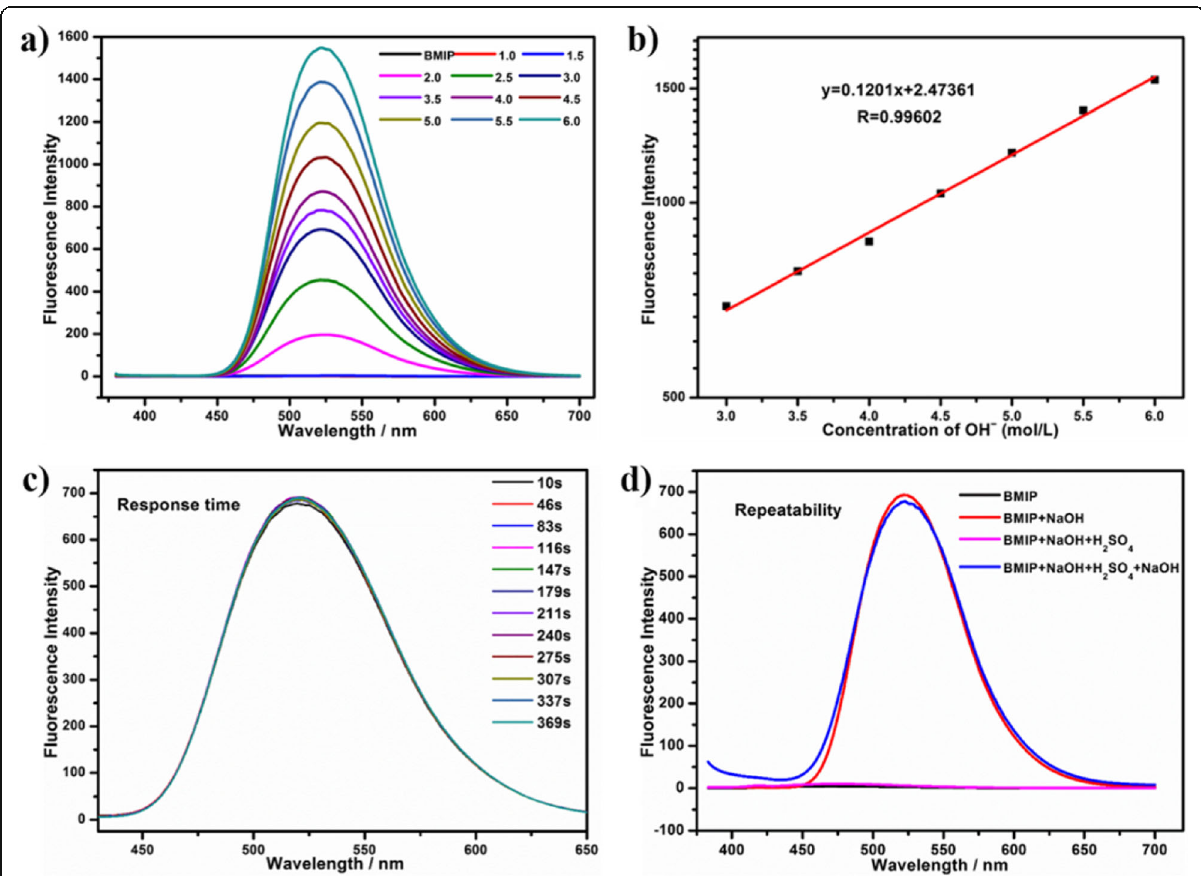
Fig. 4 a The PL spectra of aqueous solutions (1 mmol/L) of BMIP with different concentrations (0, 1.0, 1.5, 2.0, 2.5, 3.0, 3.5, 4.0, 4.5, 5.0, 5.5, 6.0 mol/ L, respectively) of OH ˉ . b The changes of fluorescence intensities of BMIP solutions (1 mmol/L) with different concentrations (3.0, 3.5, 4.0, 4.5, 5.0, 5.5, 6.0 mol/L, respectively) of OH ˉ in water. c The PL spectra of aqueous solution (3 mol/L OH ˉ ) of BMIP (1 mmol/L) at different times (10 s, 46 s, 83 s, 116 s, 147 s, 179 s, 211 s, 240 s, 275 s, 307 s, 337 s, 369 s, respectively). d The PL spectra of aqueous solutions (1 mmol/L) of BMIP (3 mL) at different conditions (black line, BMIP solution without any additives; red line, BMIP solution after adding NaOH (3 mol/L); purple line, BMIP solution after adding NaOH (3 mol/L) and then the solution pH became neutral by adding sulfuric acid; blue line, BMIP solution after adding NaOH (3 mol/L), then the solution pH became neutral by adding sulfuric acid and finally adding NaOH (3 mol/L) again)